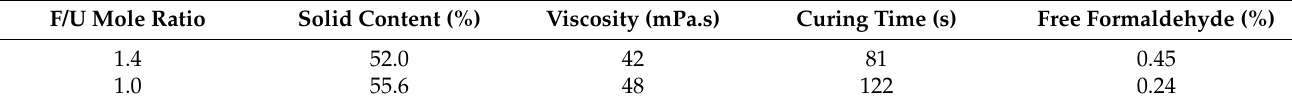
Table 1. Properties of urea–formaldehyde (UF) resins of two different mole ratios F/U. F/U Mole Ratio Solid Content (%) Viscosity (mPa.s) Curing Time (s) Free Formaldehyde